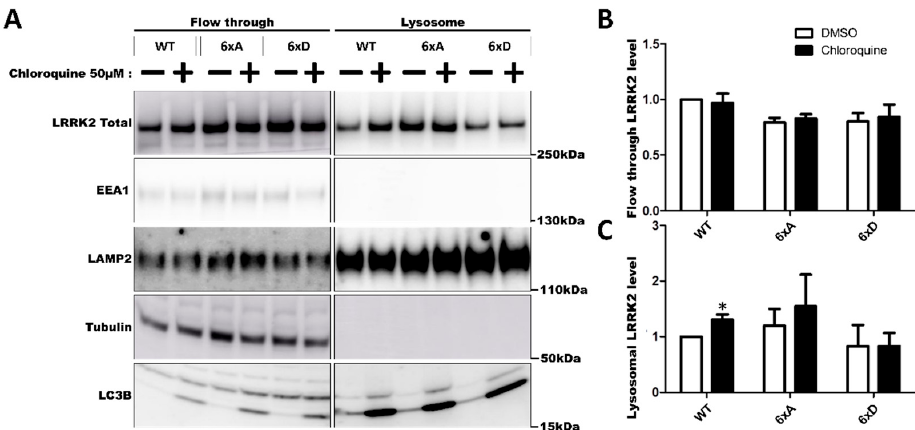
Figure 7. Abundance of LRRK2 in purified lysosomes. Lysosomes were magnetically isolated from HEK293T cells expressing 3xFLAG-LRRK2 and phosphorylation mutants as described in the Materials and Methods. Cells were treated with chloroquine 50 µM for 24 H to induce LRRK2 enrichment to lysosomes. Levels of LRRK2 in the flow through and in the lysosomes isolated are quantified by Western blotting ( A ). Relative abundance of LRRK2 in flow through ( B ) and in isolated lysosomes ( C ) is normalized with LAMP2 levels. The data represents the mean ± SEM from three independent experiments and are analyzed by one sample t-test (* p < 0.05).